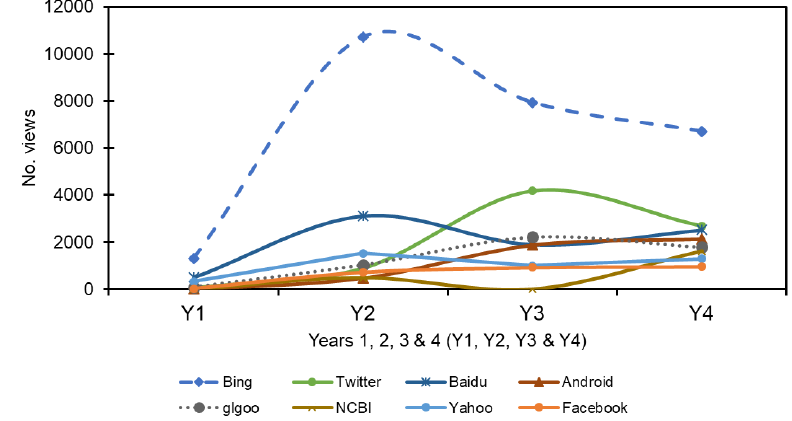
Figure 8. Top ten web traffic referral sources during Y1, Y2, Y3 and Y4, excluding Google, Google Scholar and local sources